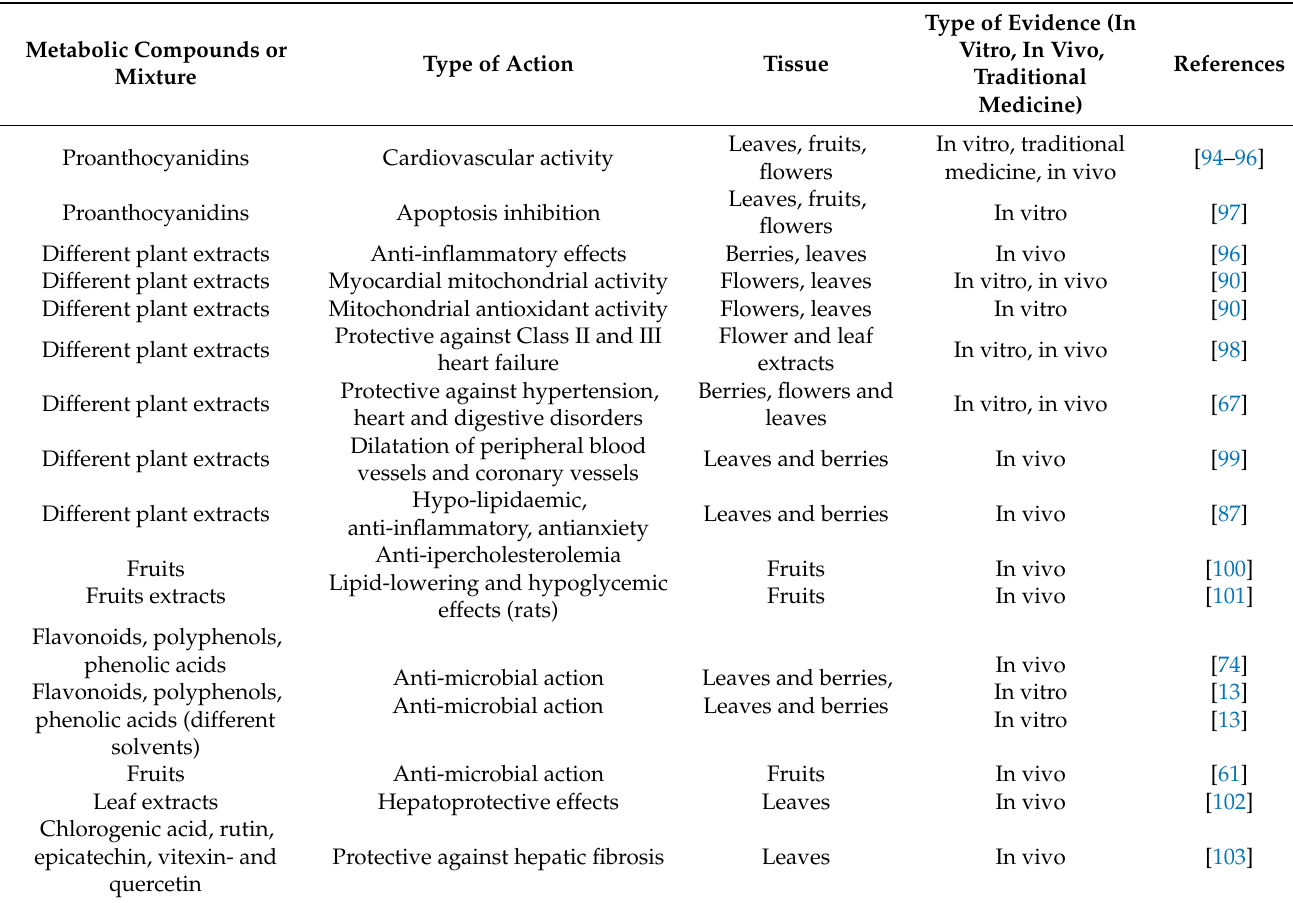
Table 1. Metabolic compounds, the mixture used in the study, action type, used plant tissues, type of evidence and references of research studies dealing with pharmaceutical properties of C. monogyna